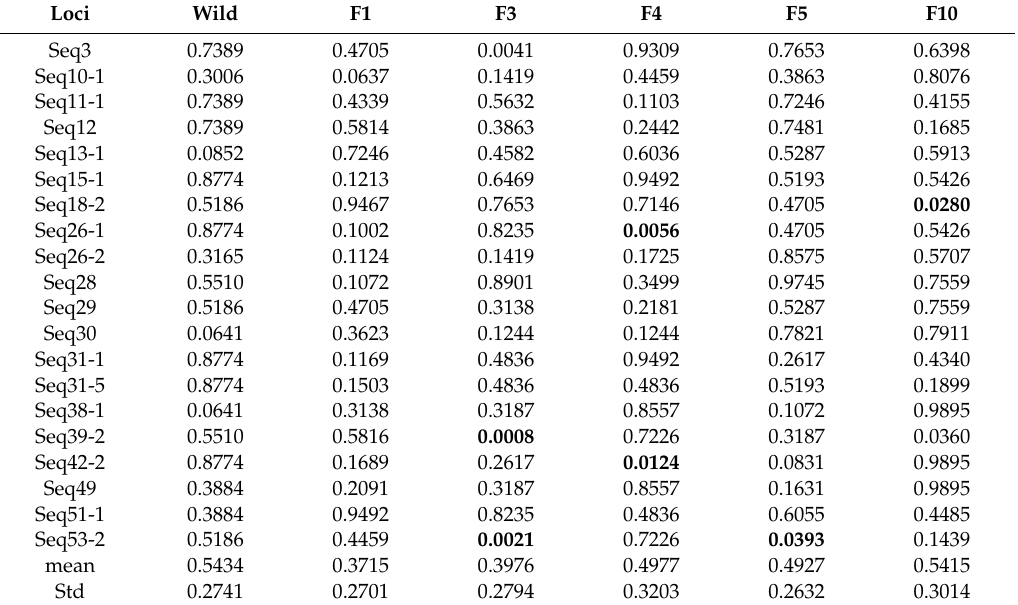
Table 2. Hardy–Weinberg equilibrium with p -value among six rare minnow populations based on 20 SNPs. Numbers in bold identify significant deviations from Hardy–Weinberg